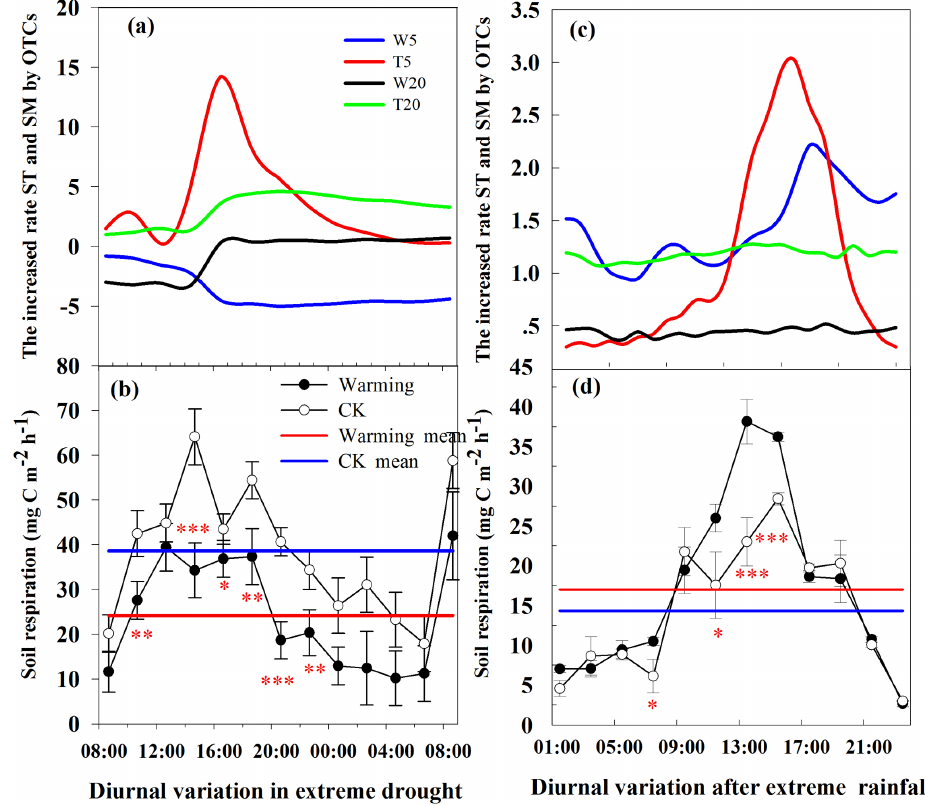
Figure 3. Post-extreme-rainfall diurnal variation in R s (mean ± SE, n = 4, d ) with variation in soil temperature and soil moisture (c) , and extreme-drought variation in R s (mean ± SE, n = 4, b ) with variation in soil temperature (T5, T20, a ) and soil moisture at 5cm (W5) or 20cm (W20) depth caused by warming in OTCs. Positive values indicate an increase due to warming, and negative values indicate decline. A red straight line indicates the average value of R s inside the OTCs in (b) and (d) , and a blue straight line represents the average value of R s out of OTCs in (b) and (d) . Red *, ** and *** symbols indicate significant effects at P <0.05, P <0.01 and P <0.001,